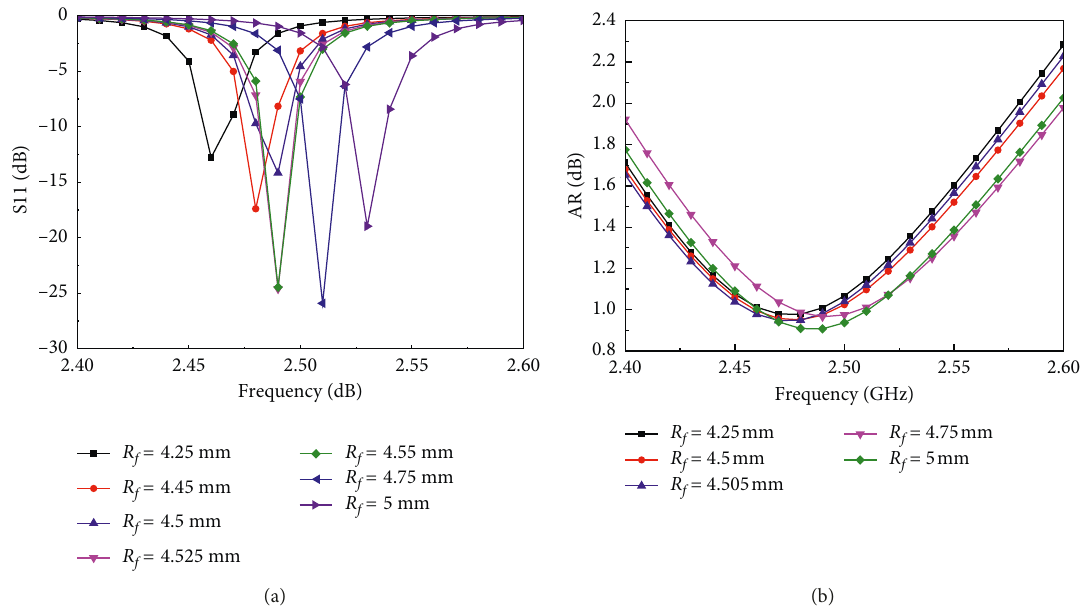
Figure 8: Effect of different R f on antenna’s performance: (a) S11 and (b)